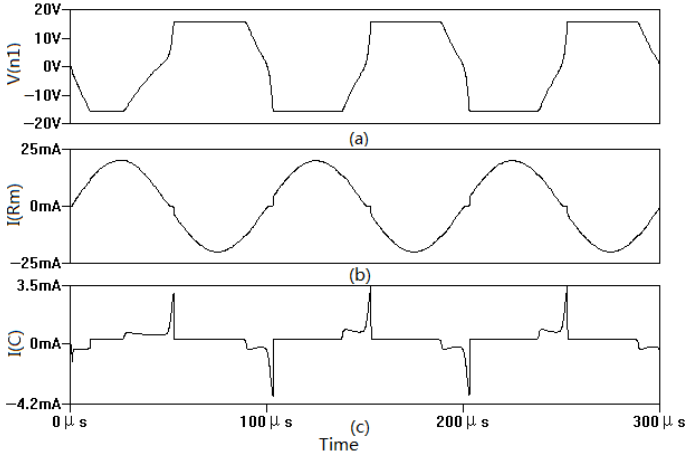
Figure 10. Simulation waveform at 100 A & 10 KHz for distortion analysis. ( a ) Voltage at node n1. ( b ) Current flowing through the sampling resistor. ( c ) Current flowing through the parasitic capacitance.